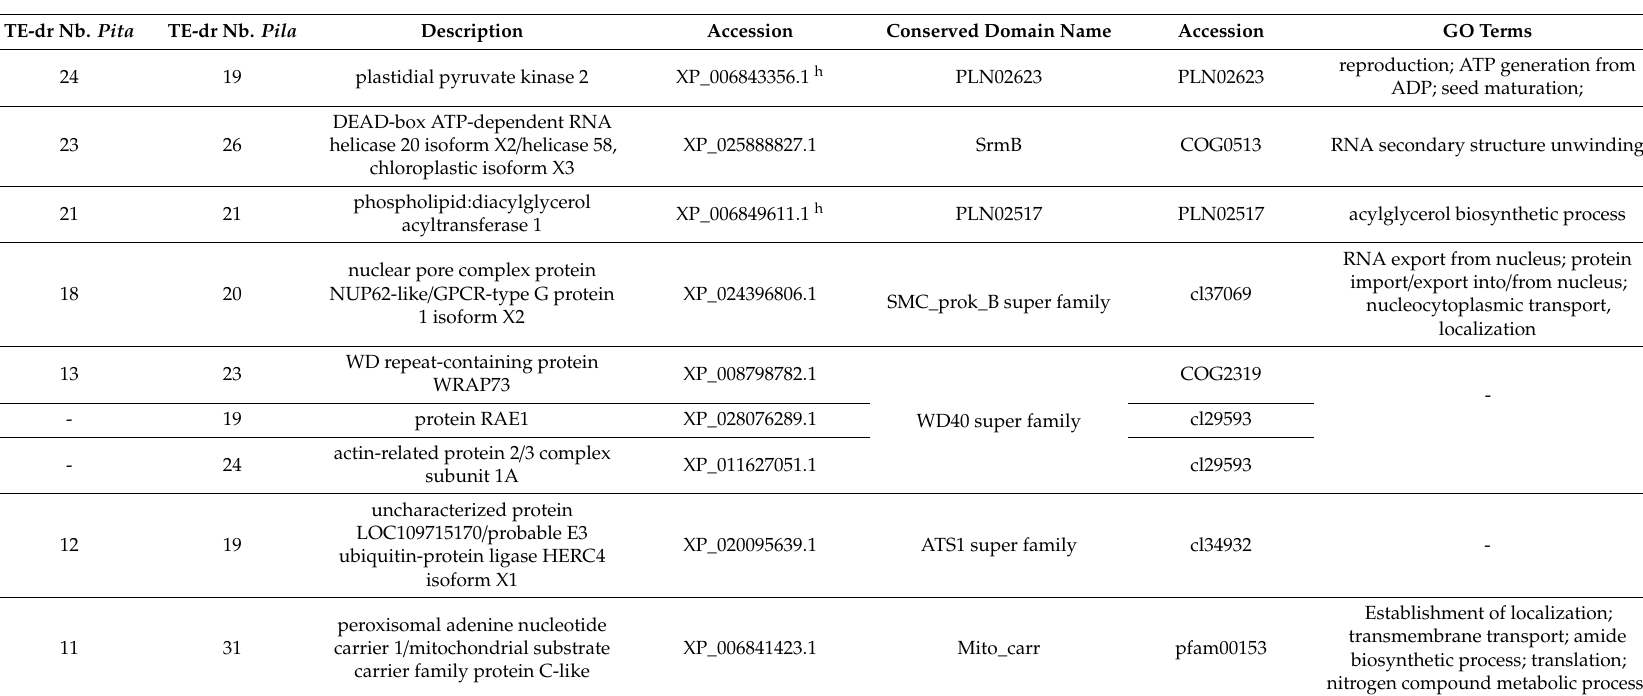
Table 3. Node genes containing several TE insertions and found to be homologous or carrying identical domains between P. taeda (PITA) and P. lambertiana (PILA). TE-dr Nb.